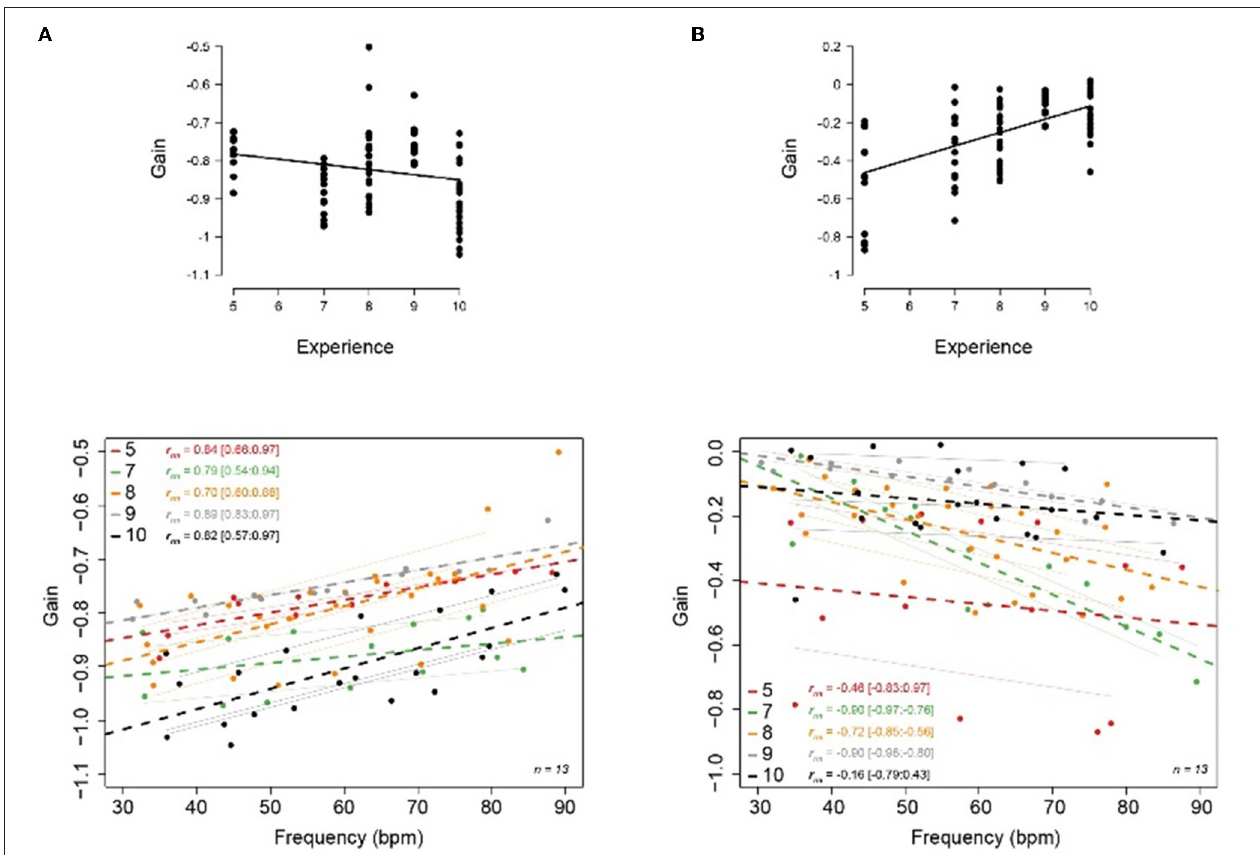
FIGURE 4 | Regression lines comparing head frequency with VOR gain during head rotation for the different skill levels (colored) and participants (light gray) for the (A) classic condition and (B) VOR suppression condition. The top panels represent group average, over all participants and the different velocities, the bottom panels represent gain regression lines for the groups (in color) and per gymnast